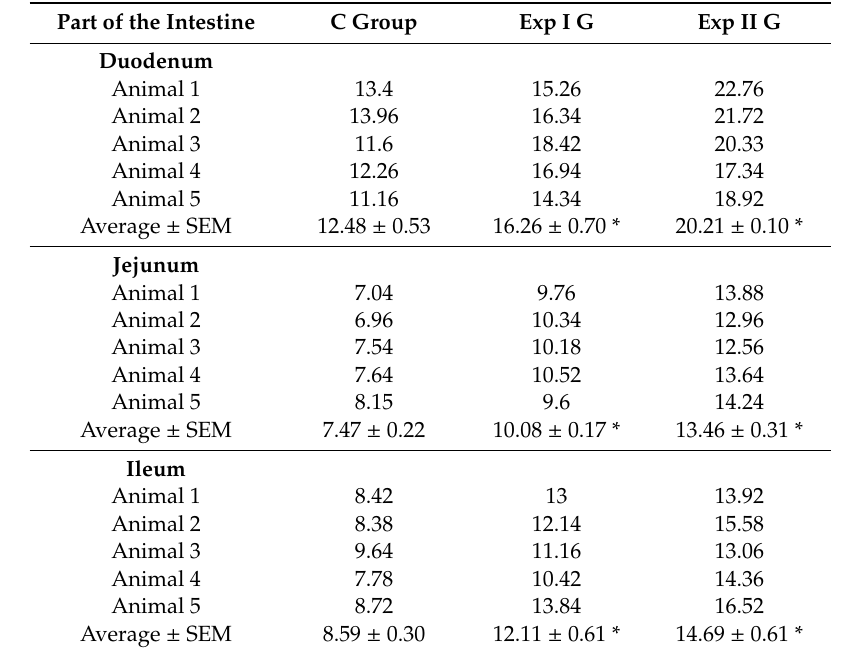
Table 1. The average number of serotonin-positive cells (per microscopic observation field—0.15 mm 2 ) in the mucosal layer of the porcine small intestine in control animals (C group) and in animals treated with low (Exp I G) and high (Exp II G) doses of bisphenol